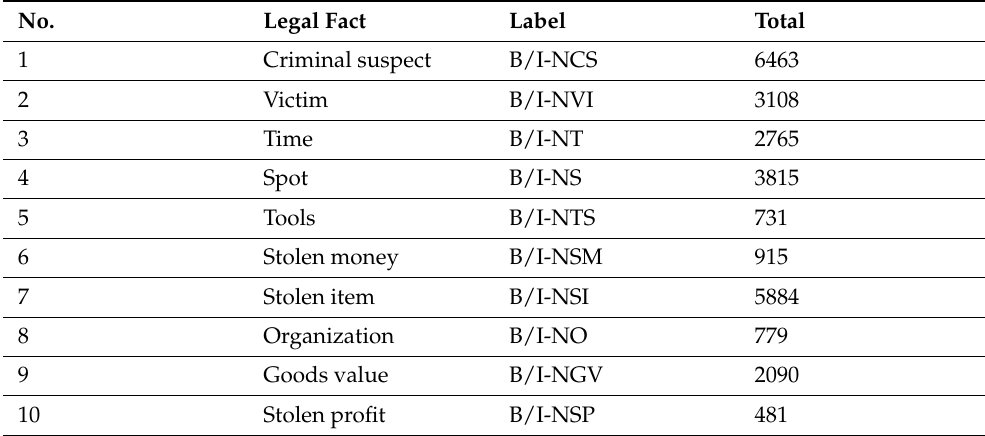
Table 3. Statistics of the CAIL2021_IE dataset.